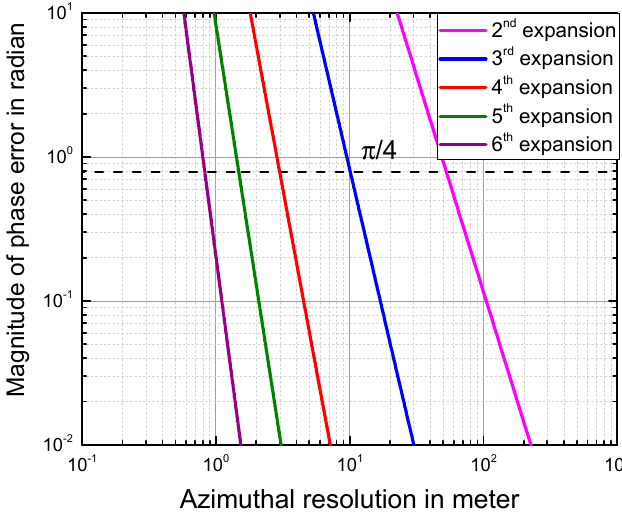
Figure 14. Relationship between the azimuthal resolution and phase error caused by different expansion orders. Table 2. Relationship between azimuthal resolution and valid expansion orders.